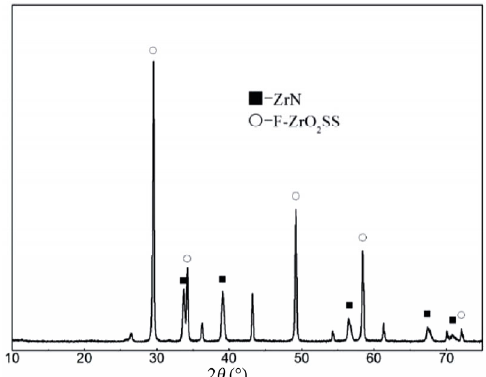
Fig. 6 XRD pattern of the sample with ZrN:ZrO 2 :Y 2 O 3 = 4:3:3.